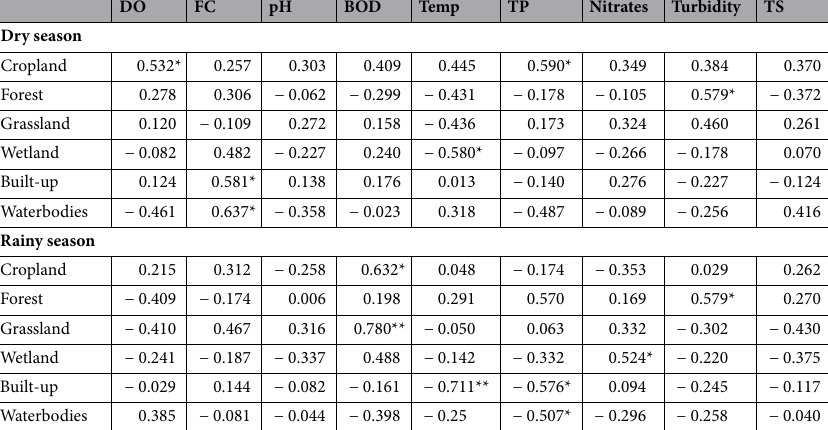
Table 5. Pearson correlation coefficients between LULC types and water quality parameters in the dry and rainy season. *Correlation is significant at the 0.05 level (2-tailed). **Correlation is significant at the 0.01 level (2-tailed).